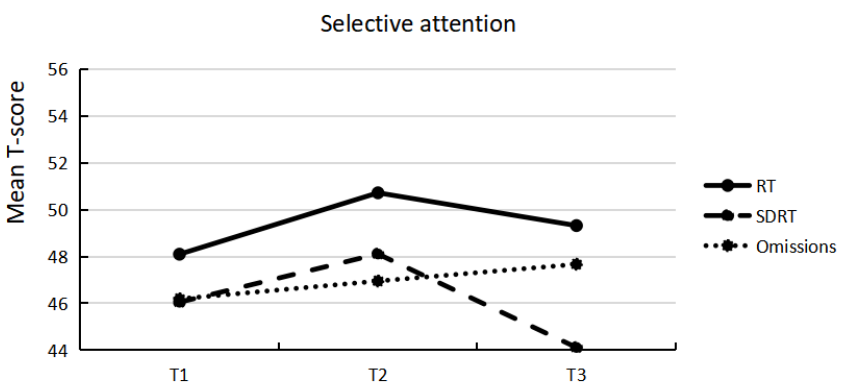
Figure 1. Mean T-score of variables of selective attention at each of the three assessments.